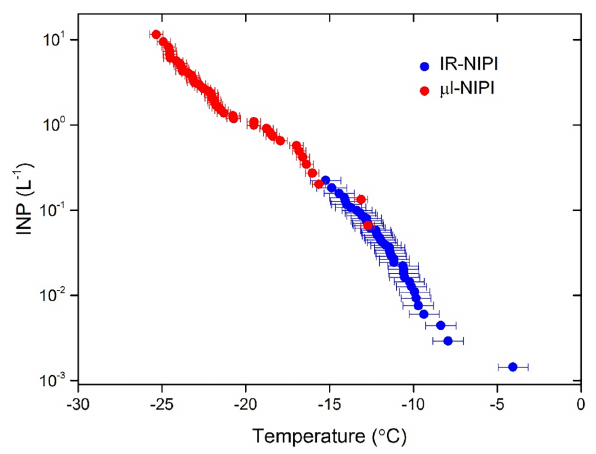
Figure 9. INP concentrations per litre of air sampled on 5 Novem- ber 2017 in Leeds. Aerosol were collected onto filters for later ex- traction into water and analysis of the resulting suspensions with the IR-NIPI and µL-NIPI